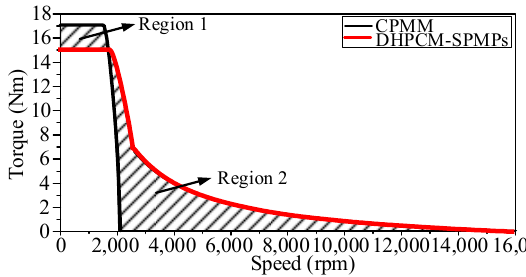
Figure 16. The efficiency map of CPMM.